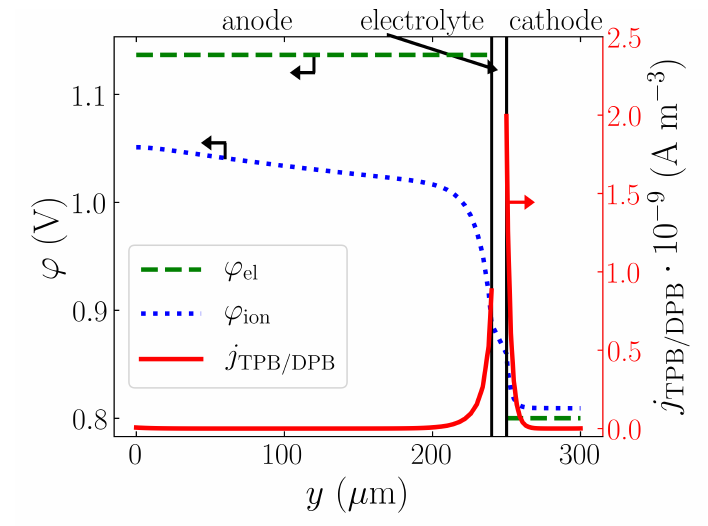
Figure 12. Distribution of the averaged electronic and ionic potentials, and the average volumic current density in cell depth direction.